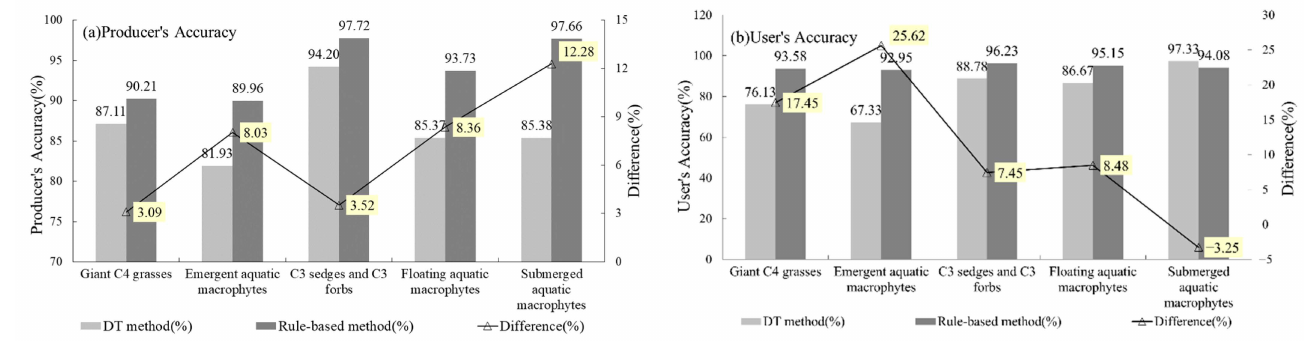
Figure 9. Comparison of ( a ) user’s and ( b ) producer’s accuracy between decision tree (DT) and rule-based